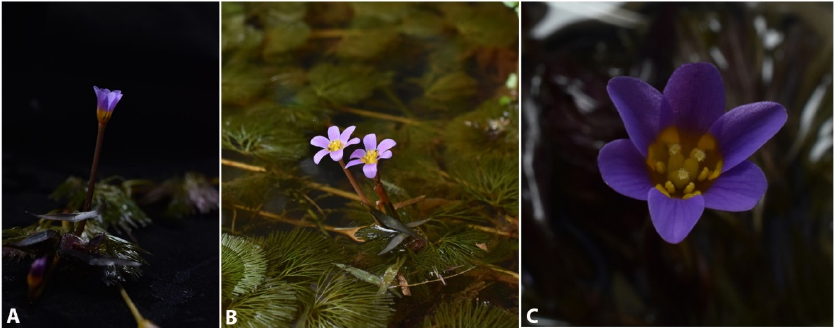
Figure 2: A. Floral habit of Cabomba furcata; B. Flowers emerged out of the water surface and C. A closer view of the